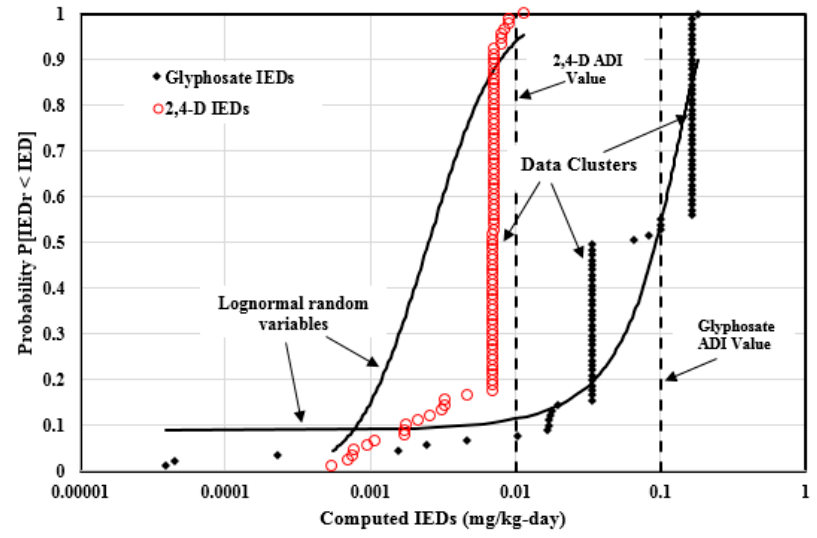
Figure 7. 2,4-D and Glyphosate agricultural commodities implied exposure doses (IEDs) plotted in the empirical cumulative distribution forms and compared to the log-normal random variable cumulative distributions with identical statistics.